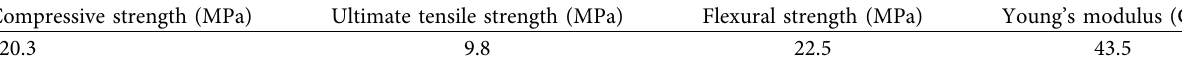
Table 2: Material properties of UHPC.